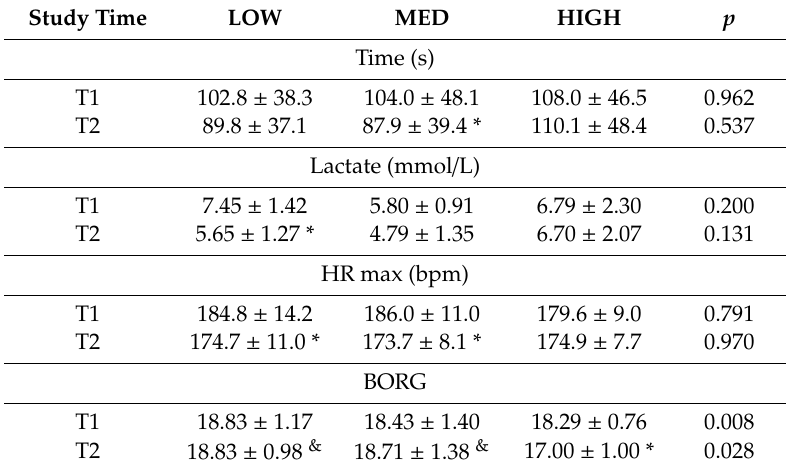
Table 3. Results of the aerobic power-capacity test in low (LOW), medium (MED) and high (HIGH) groups before (T1) and after (T2) completing the competition. Study Time LOW MED HIGH p Time (s) T1 102.8 ± 38.3 104.0 ±